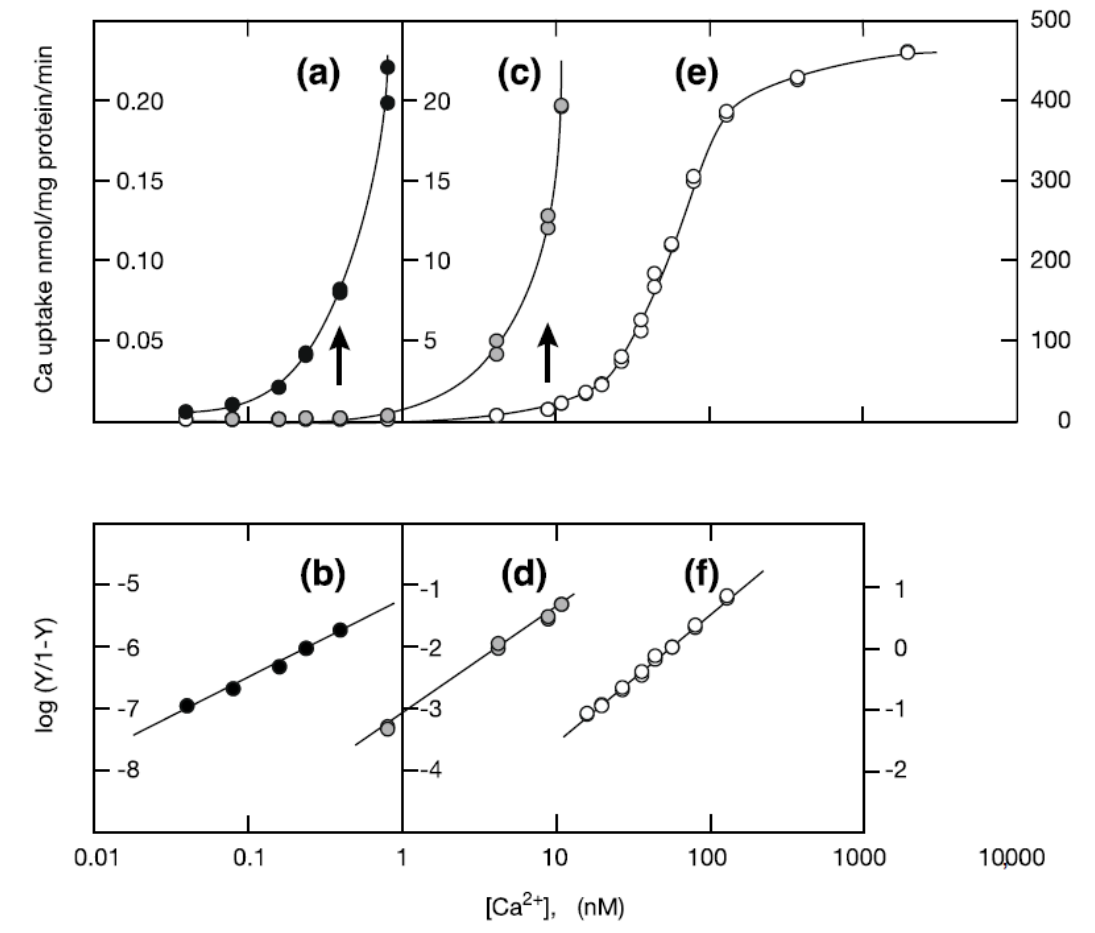
Figure 1. Calcium dependence of Ca 2+ -transport activity in the 0.04 nM–9.9 µM Ca 2+ concentration range and the change of the Hill coefficient; the Hill coefficient is a parameter that indicates the degree of the cooperativity in binding calcium ions at the Ca 2+ -ATPase. ( a , c , e ) Calcium dependence of the transport activity. (b , d , f ) The corresponding Hill plots. Y is the ratio of the transport activity at each calcium concentration to the maximum activity (445 nmol Ca/mg of protein/min). ( a , b ) 0.04–0.81 nM Ca 2+ ( black filled circles ). ( c , d ) 0.04–11 nM Ca 2+ ( grey circles ). ( e , f ) 0.04 nM–9.9 µM Ca 2+ ( unfilled circles ). The ordinates of Ca 2+ -transport activity and log (Y/1-Y) shown at the left, middle and right Y-axes in this figure, correspond to their values in ( a and b ), ( c and d ), and ( e and f ), respectively.